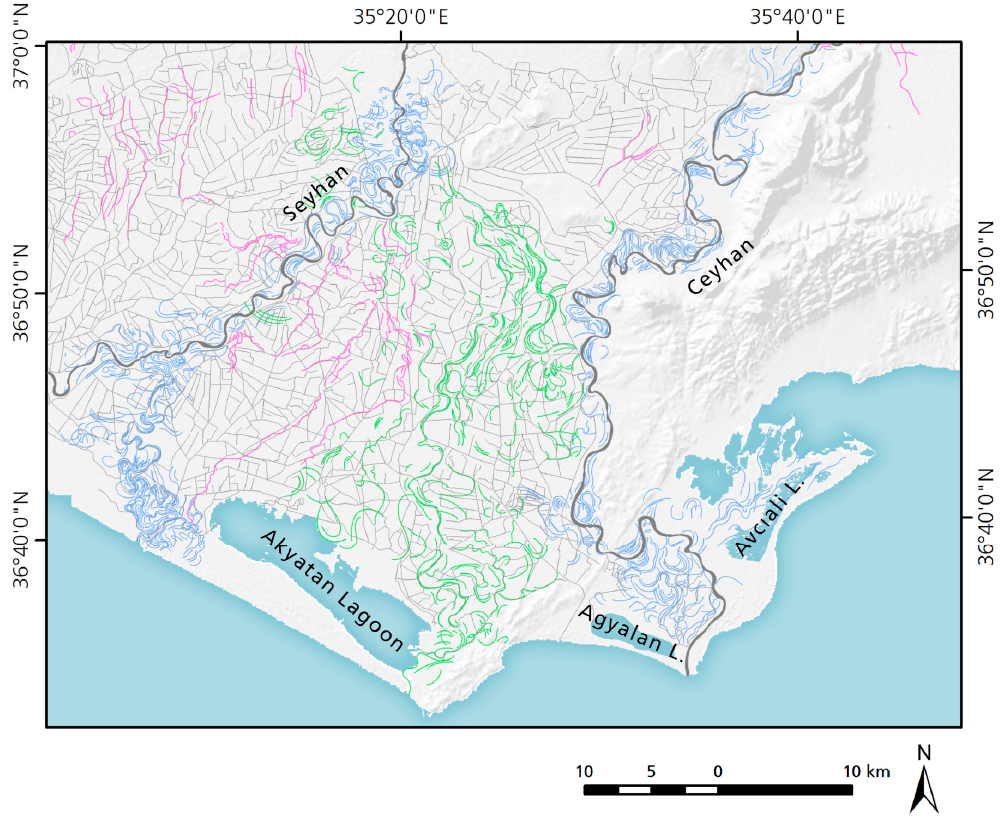
Figure 16. Modern river courses (grey), palaeochannels (blue, green) and relict canals (pink) in the Çukurova. The network of thin grey lines shows the modern network for canals for irrigation (mapped based on freely available VHR data in ArcGIS) © Susanne Rutishauser.